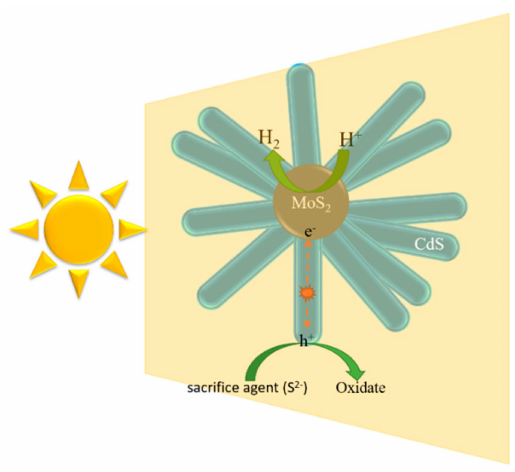
Figure 10. Schematic of photogenerated charge transfer and photocatalytic reaction over the MoS 2 QDs/CdS under visible light